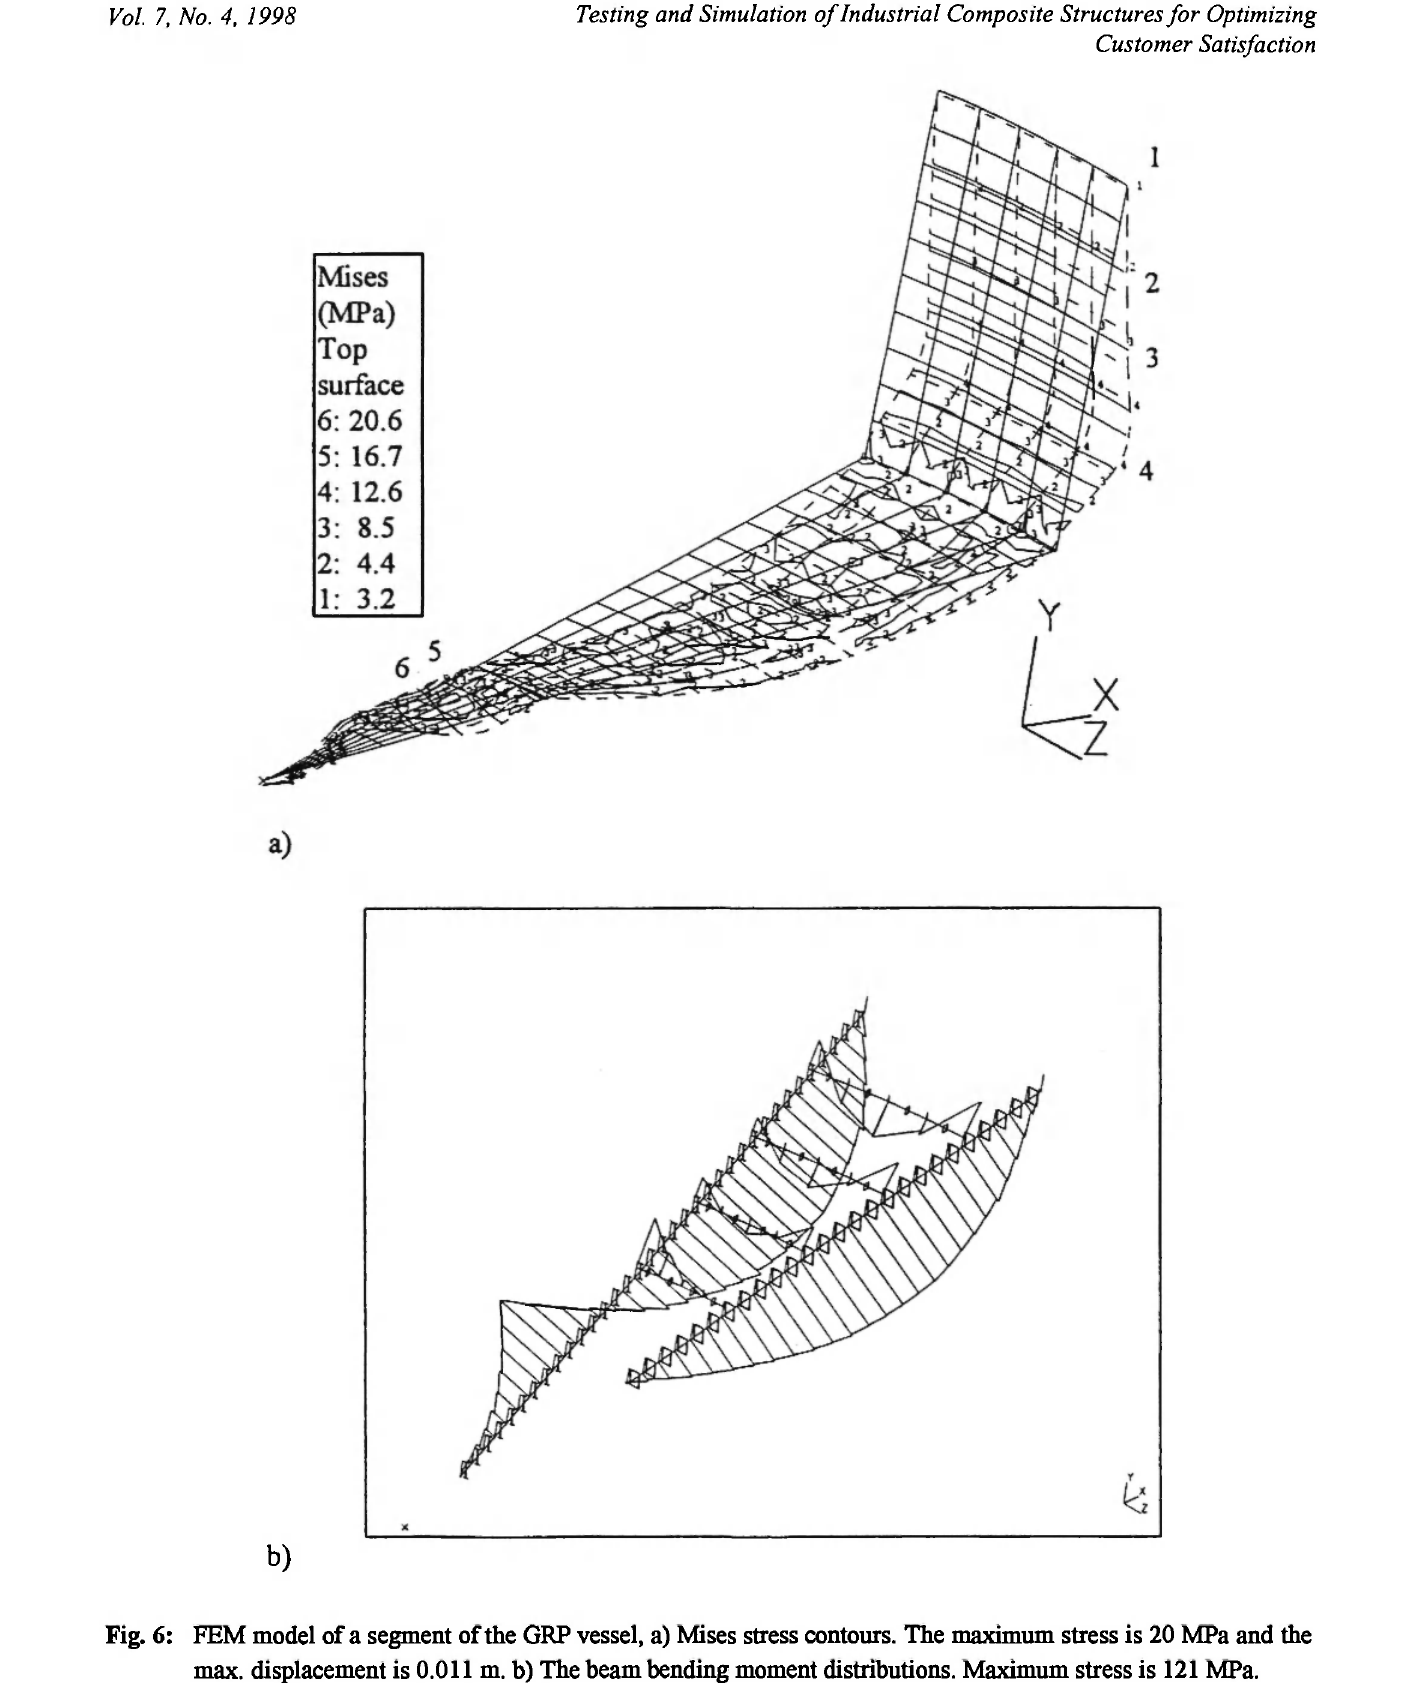
Fig. 6: FEM model of a segment of the GRP vessel, a) Mises stress contours. The maximum stress is 20 MPa and the max. displacement is 0.011 m. b) The beam bending moment distributions. Maximum stress is 121